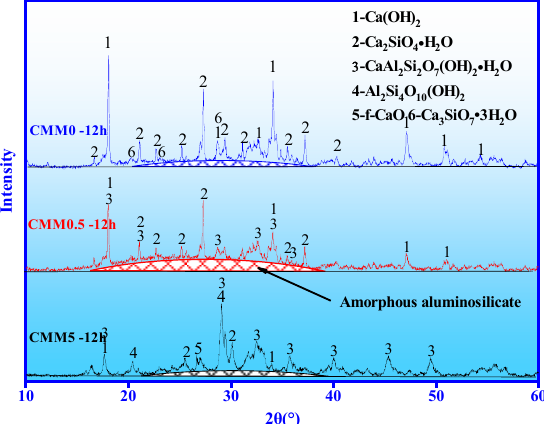
Figure 12. XRD results of CMM0.5 at 6, 9 and 12 h.